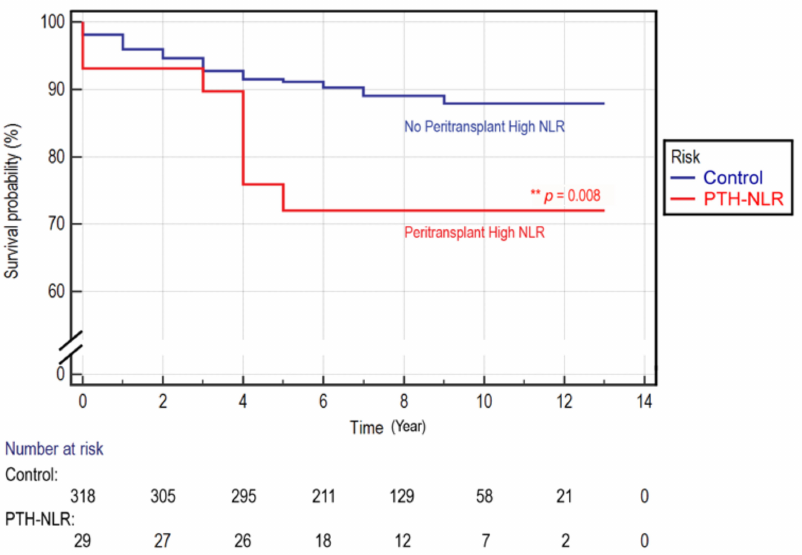
Figure 1. Kaplan–Meier overall survival curve in LT patients of HCC. A survival comparison for LT patients with or without peritransplant high NLR values. The mean survival for the patients with peritransplant high NLR (PTH-NLR) versus the non-persistent controls was 11.84 ± 0.19 versus 10.21 ± 0.85. The 1-, 3- and 5-year overall survival rates of control versus PTH-NLR group were 95.9%, 92.8%, and 91.1% versus 93.1%, 89.7%, and 72.1%, respectively ( p =